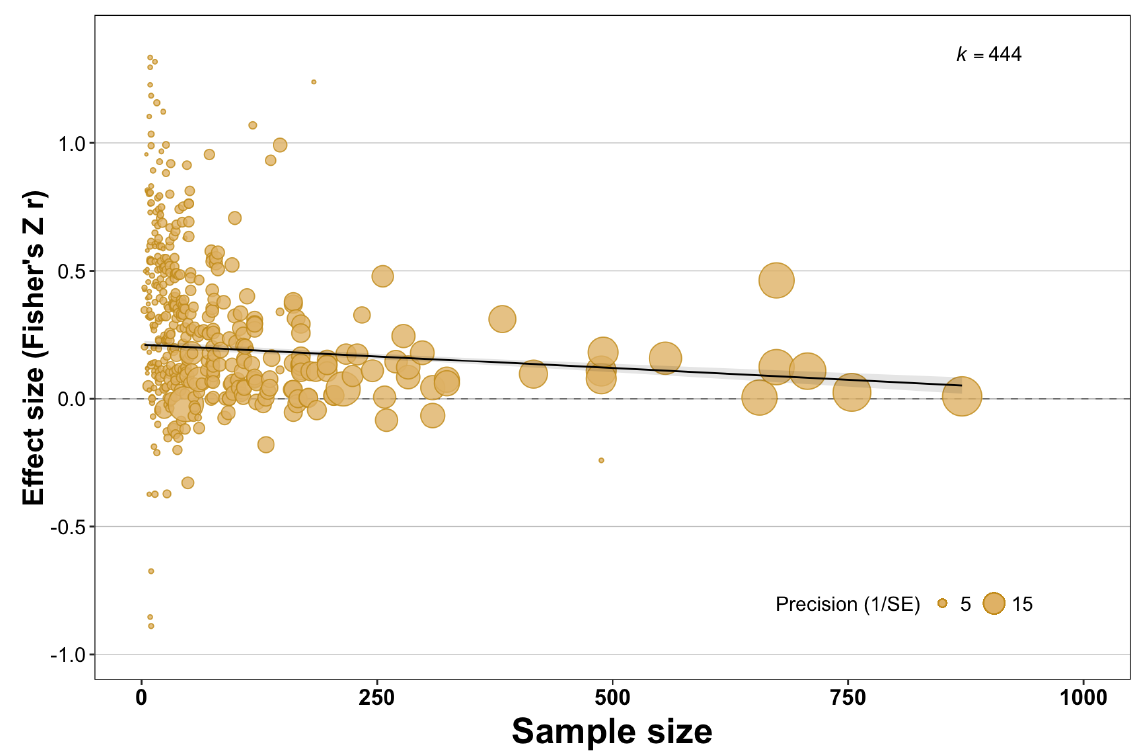
Figure 3. Relationship between the effect size of dominance rank on female reproductive success and the sample size of the study. Studies with smaller sample sizes show more extreme effect sizes, and also indications of potential publication bias as there are more extremely positive values than what would be expected based on the average effect sizes of studies with larger sample